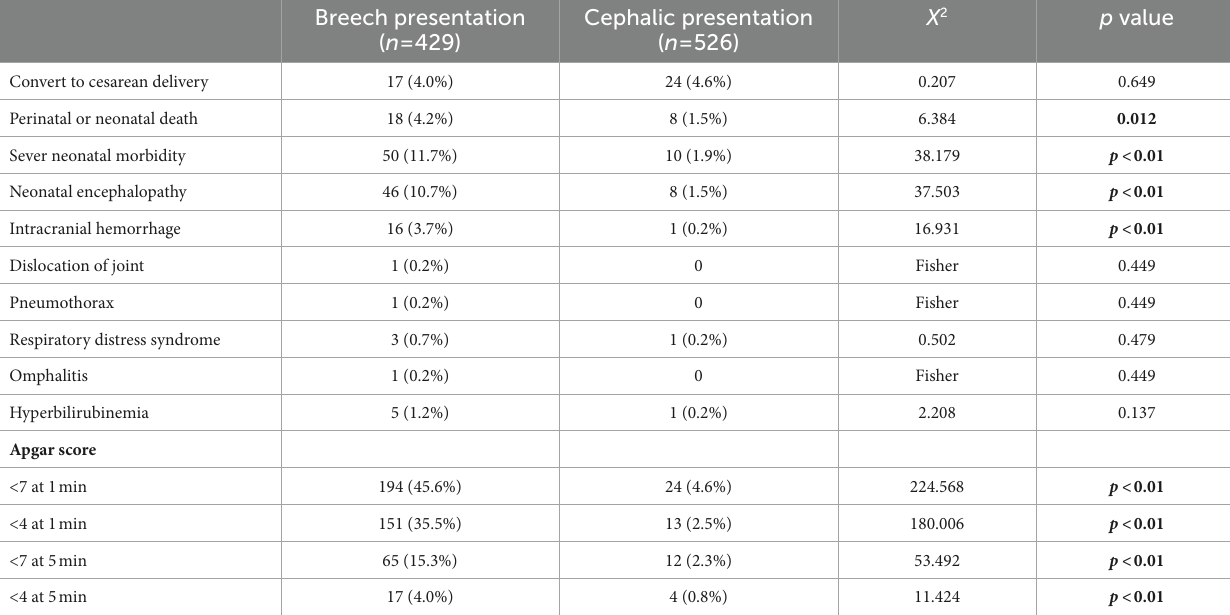
TABLE 4 Primary outcome of term infants between breech and cephalic presentation.